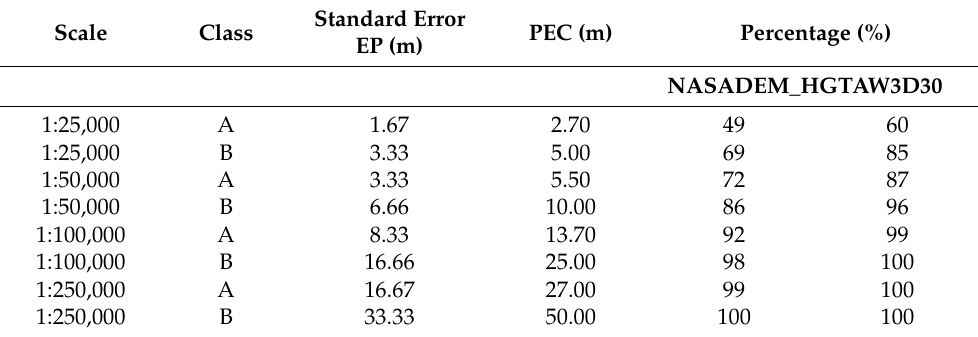
Table 7. Percentage of points that presented discrepancies lower than the Cartographic Accuracy Standard (PEC) (m).